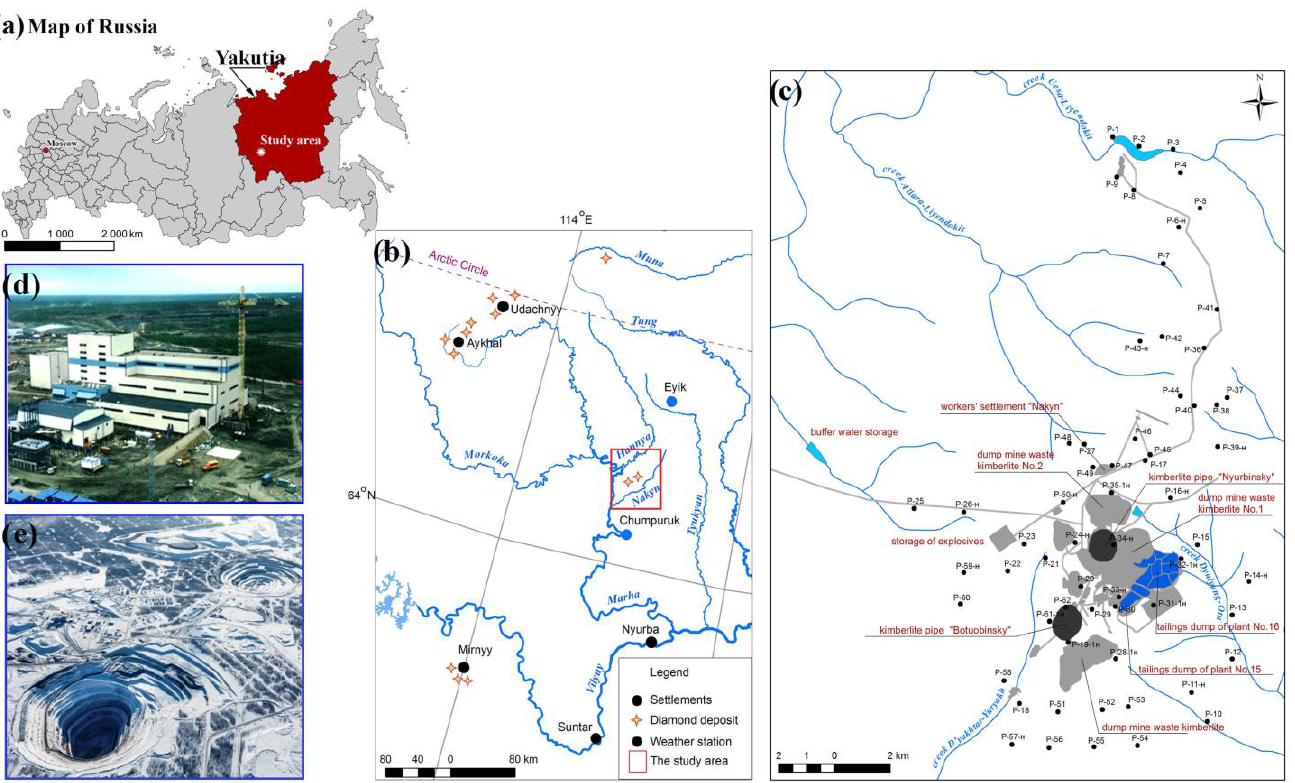
Figure 1. Location of the study area: ( a ) location of the study area on the map of Russia, ( b ) photo of the Nyurbinsky mining and processing division territory, ( c ) soil sampling scheme, ( d ) photo of plant no. 16, and ( e ) Nurbinsky and Botuobinsky open pits.